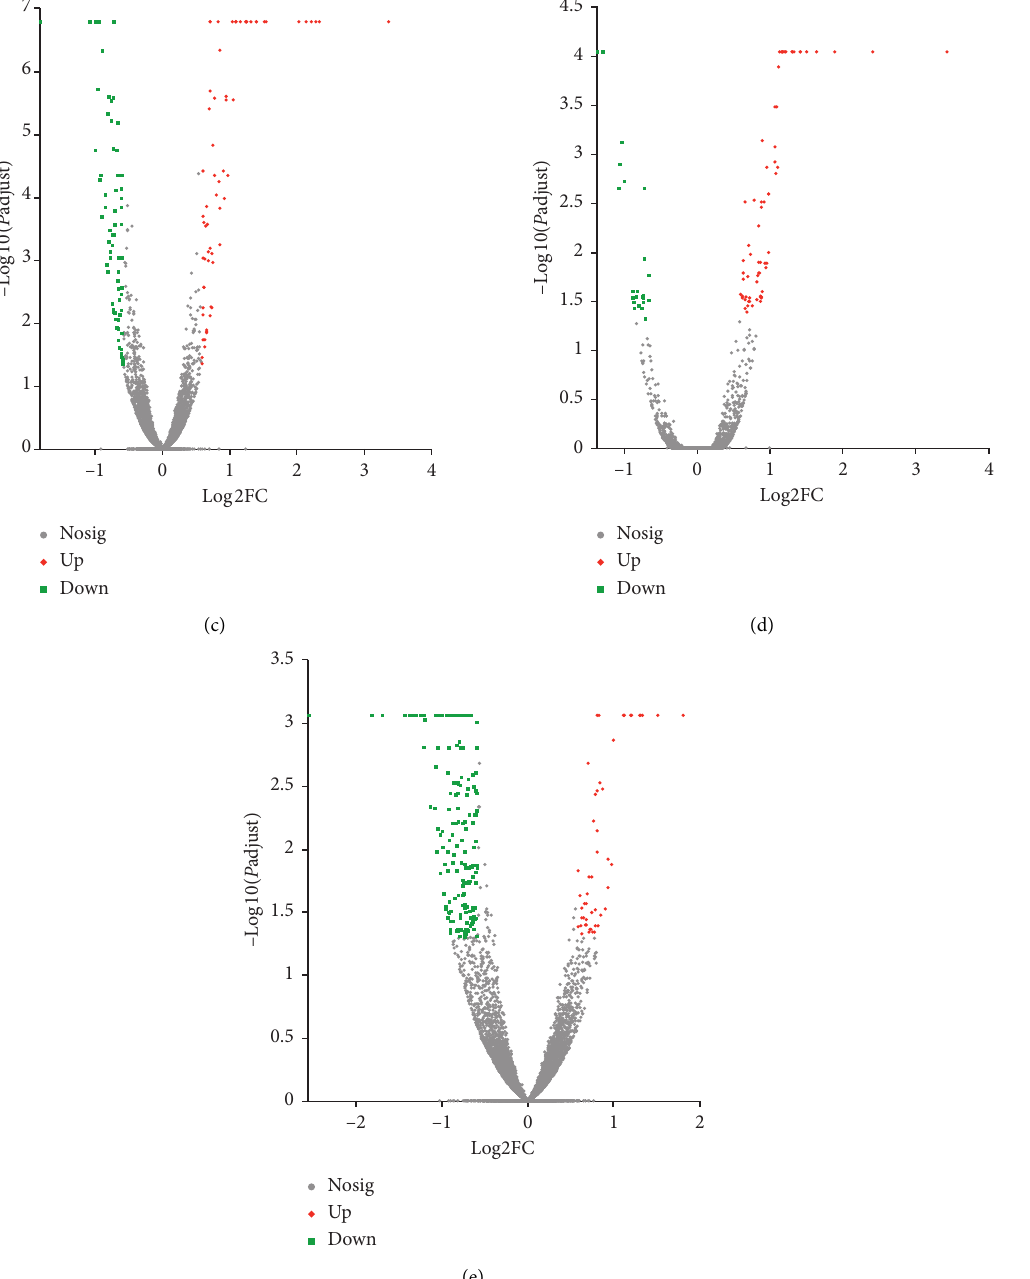
Figure 2: Analysis of differentially expressed genes. (a) Each column in the graph represents a sample, and each row represents a gene. The color in the graph represents the size of the gene expression in the sample. Red represents the higher expression of the gene in the sample, while green represents the lower expression. See the number label under the upper left color bar for the change trend of the specific expression. On the left is the tree graph of gene clustering and the module graph of subclustering, on the right is the name of the gene. The closer the two gene branches are, the closer their expression is. On the top is the tree graph of sample clustering, and on the bottom is the name of sample. (b) Genes, in which the circles of different colors in the numerical generation represent the common or unique number of genes between two or three sets of gene sets, the sum of all numbers in the circle represents the total number of genes in the gene set, and the cross region of the circle represents the common number of genes among the gene sets. (c), (d), and (e) volcanic maps are used to represent two groups of DEGs. Horizontal and vertical axes show the difference of gene expression in different groups. The smaller the P value, the more significant and the larger the difference—log10 (adjusted P value). Different genes have different splashes. There is no significant difference between grey dot genes, red dot genes, and green dot